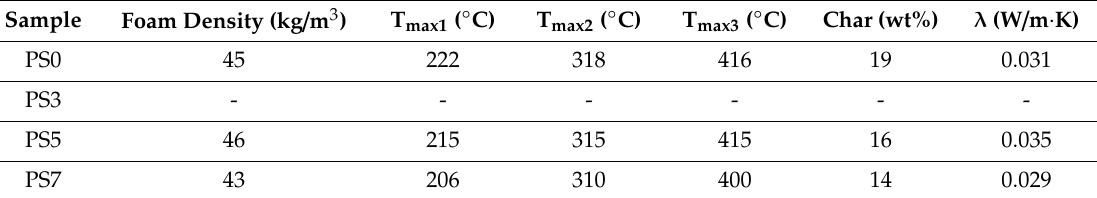
Table 4. Thermal properties of PS0, PS3, PS5 and PS7